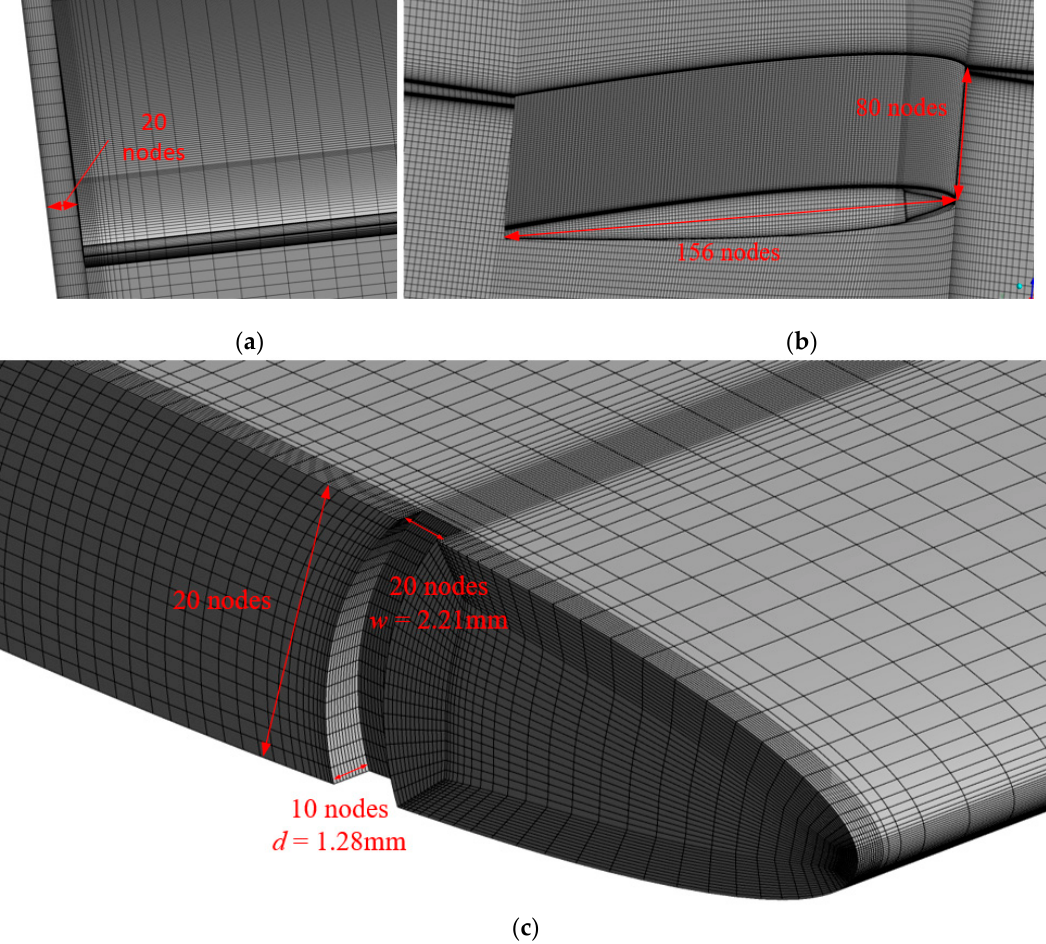
Figure 4. Grid arrangement : ( a ) refined grid in tip clearance; ( b ) refined grid around the foil; ( c ) refined grid in the groove.